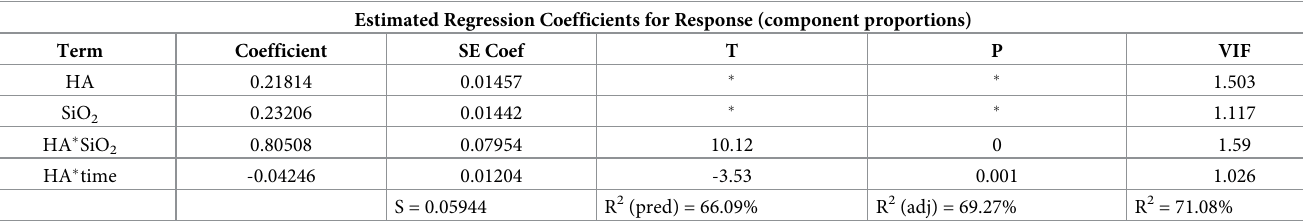
Table 1. Regression analysis for mixture process variable model of values at 24 h and 48 h. Estimated Regression Coefficients for Response (component